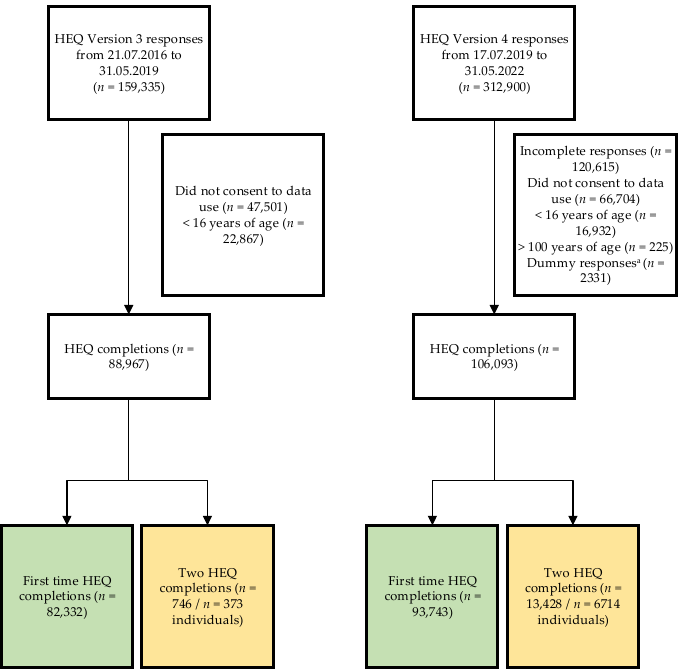
Figure 1. Flow diagram of participants . a Dummy responses include test completions by the research team, non ‐ authenticated email addresses.